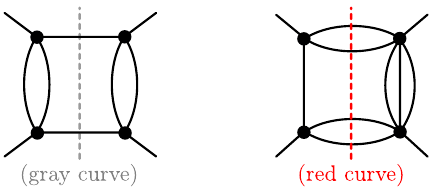
Figure 8: Diagrams with a single s -channel cut which splits each diagram into a pair of t -channel bubbles. The Landau curves of these diagrams follows from the singularities of the bubbles, which are simple normal thresholds. The Landau curve of the diagram on the left (gray curve in figure 5) is given by equation (16) while the diagram on the right (red curve in figure 5) has Landau curve given by equation